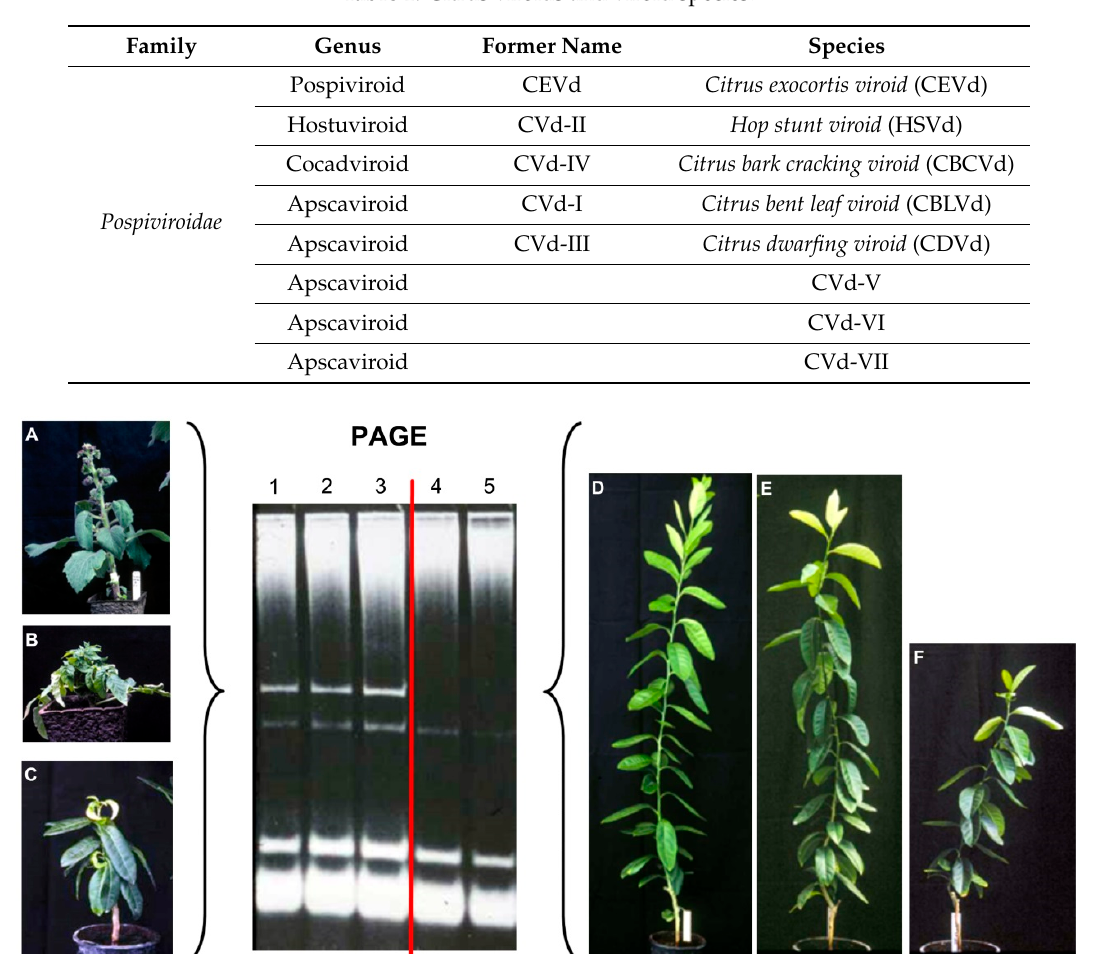
Table 1. Citrus viroids and viroid species.